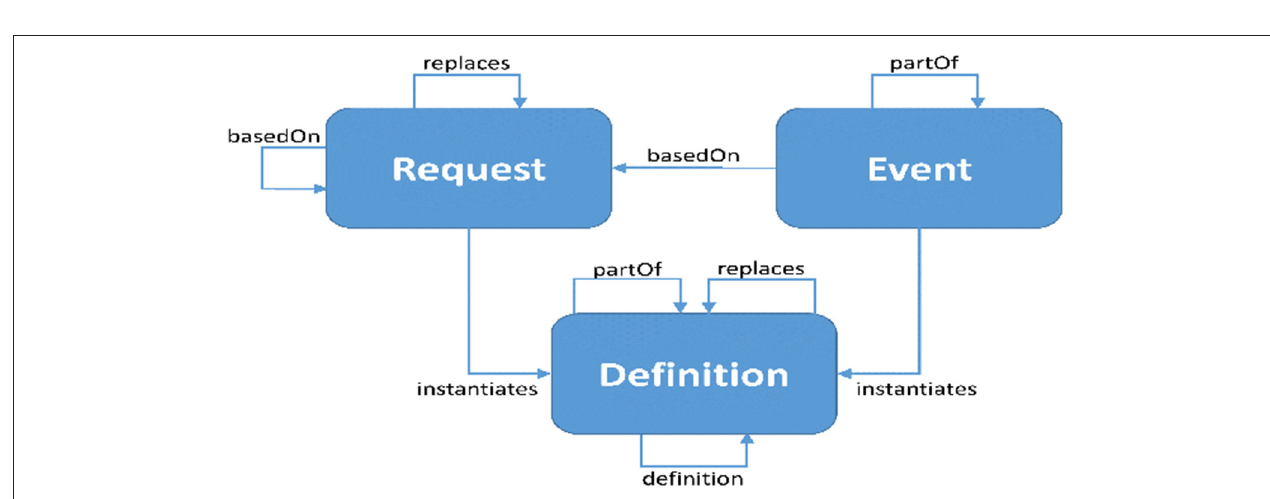
FIGURE 3 | Work flow relations Fast Health Interoperability Resources (FHIR) standard